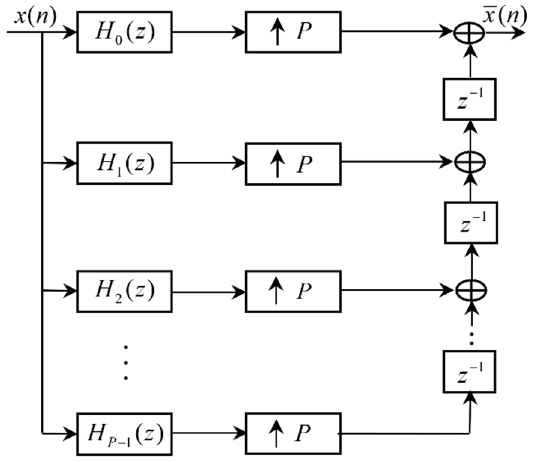
Figure 8. Proposed polyphase architecture of the interpolation